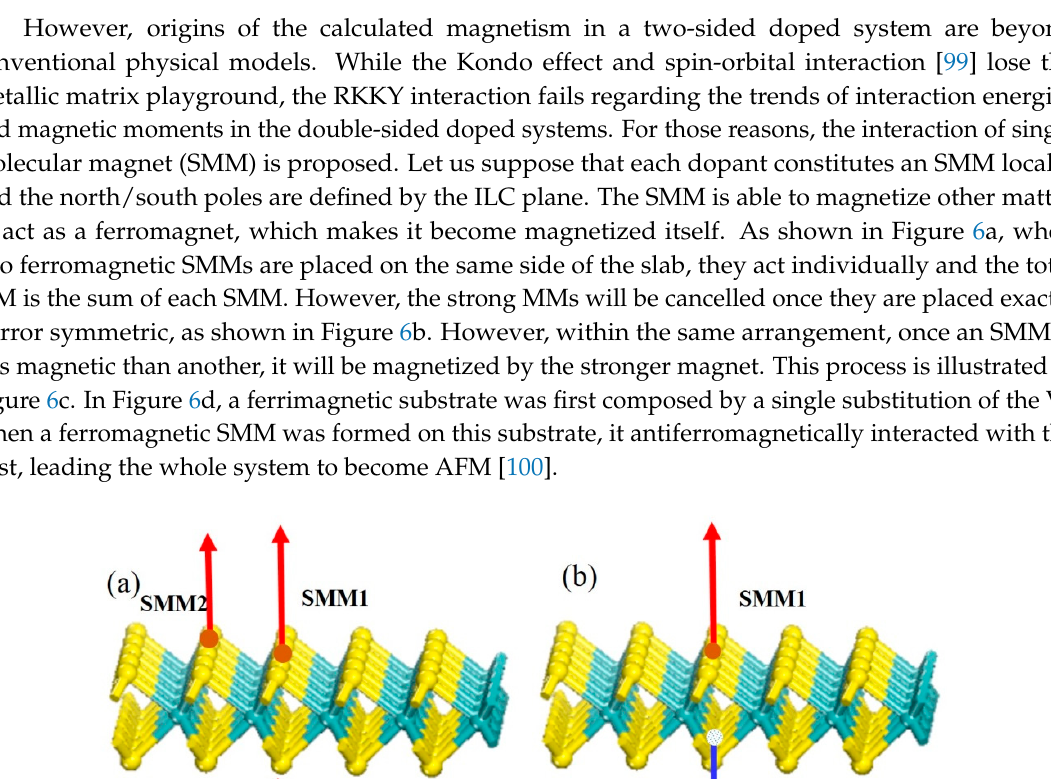
Figure 5. Illustration of the symmetries of the double-sided TM (1 or 2)-doped MoS 2 10 × 10 supercell. Defined by TM0, the symmetries of other TMs vary according to their displacement from the center of the 5 × 5 supercell.